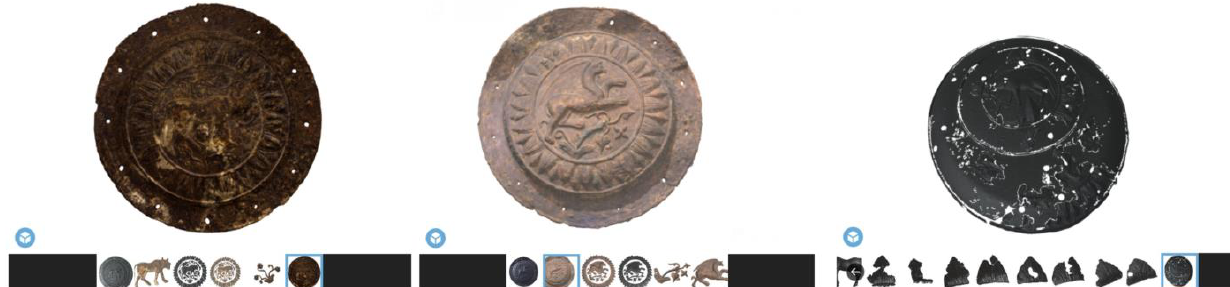
Figure 21. Interactive 3D database of the three currently available Dacian embossed disks.